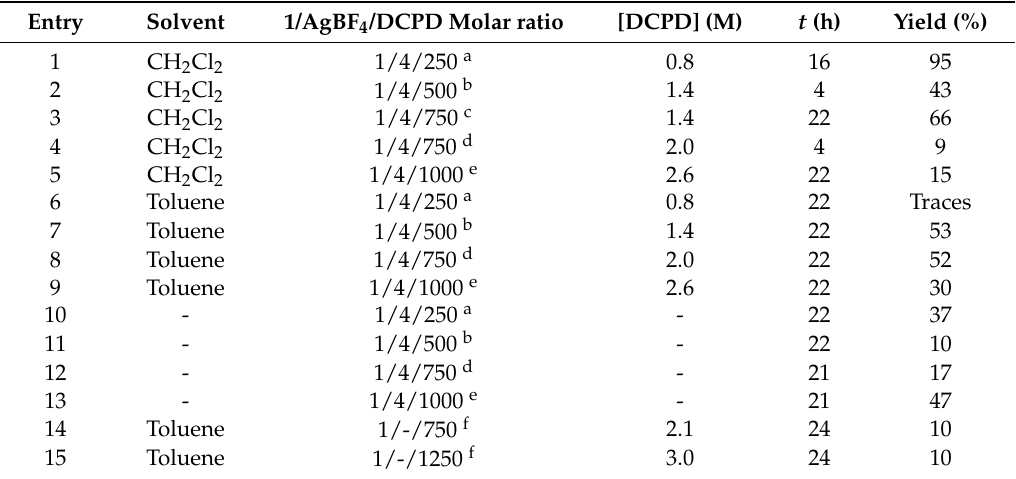
Table 6. Polymerization of dicyclopentadiene (DCPD) with the catalytic system 1 /AgBF 4